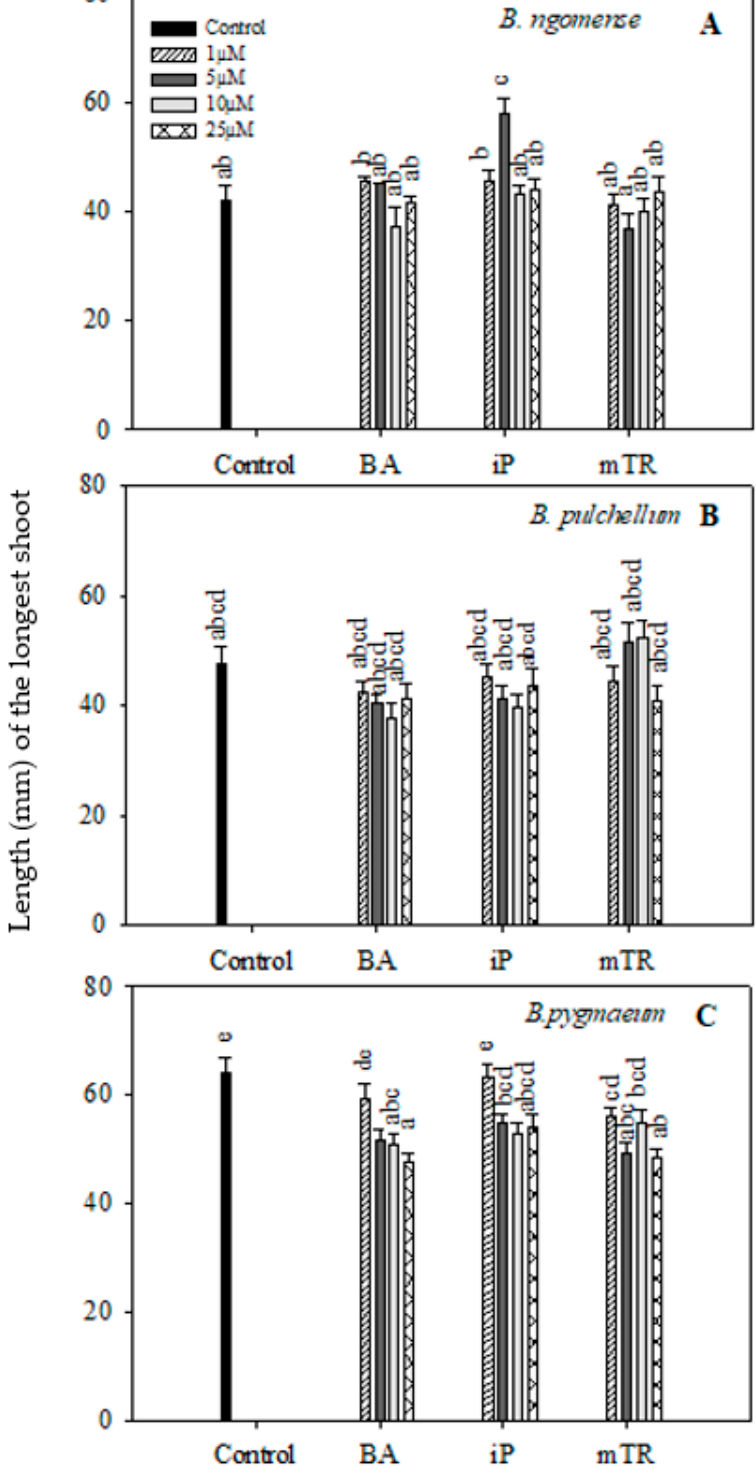
Figure 2. Effect of varying concentrations of cytokinins on the shoot length (mm) of ( A ) Brachystelma ngomense , ( B ) Brachystelma pulchellum and ( C ) Brachystelma pygmaeum after six weeks in culture. In each graph, different letter(s) on the bars show significant differences according to Duncan’s multiple range test (DMRT) ( p ≤ 0.05). N 6 -benzyladenine (BA), isopentenyladenine (iP) and meta -topolin riboside ( m TR).